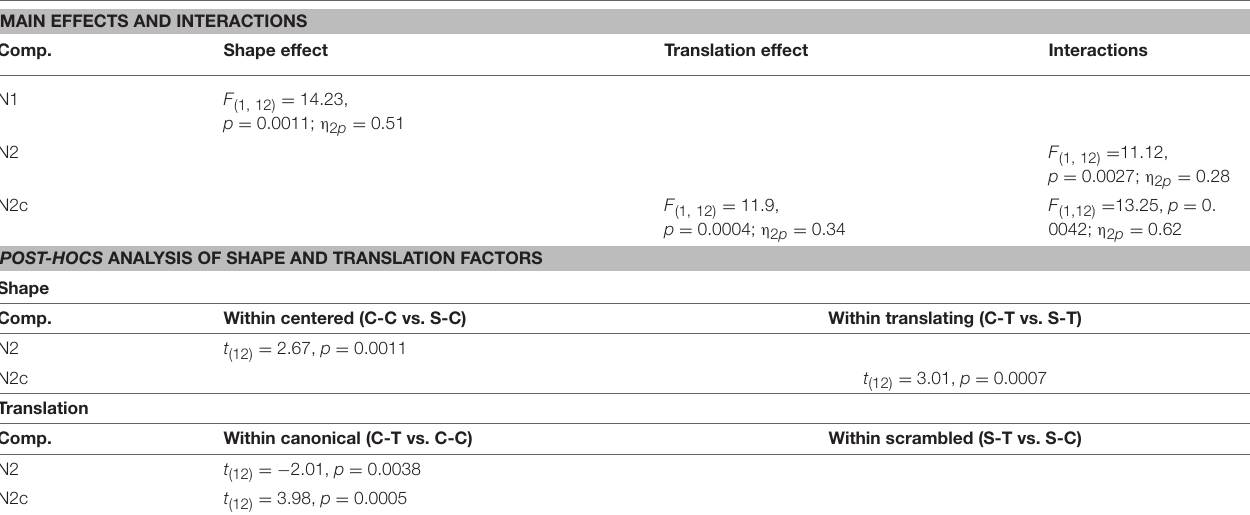
TABLE 4 | Statistical analysis on the not-pursuing group.